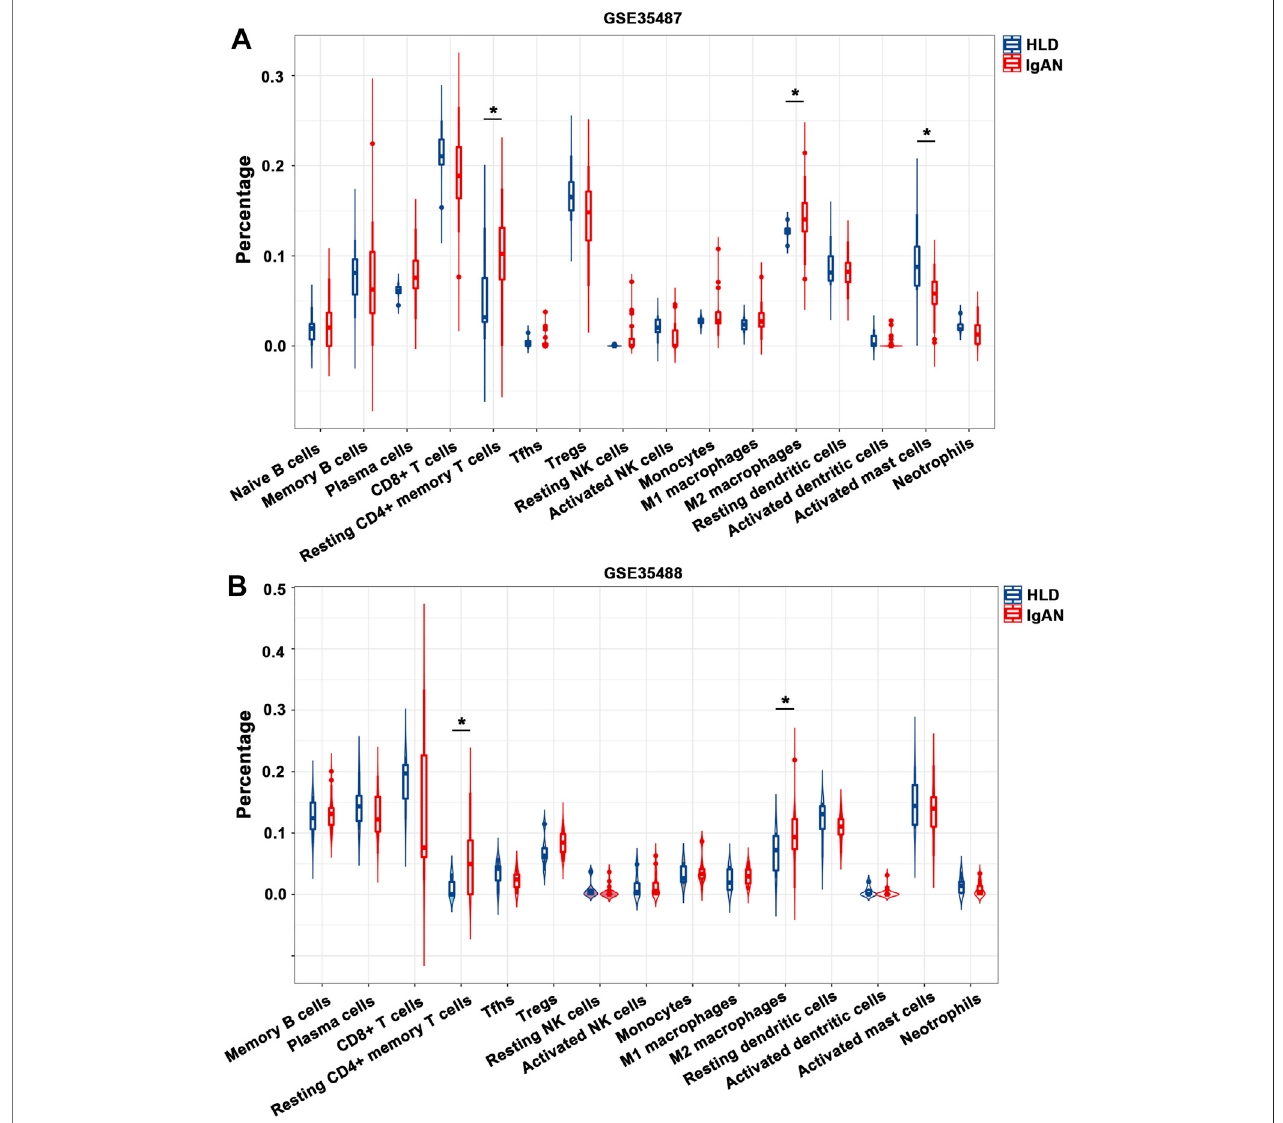
FIGURE 6 | Composition of in fi ltrating immune cell subpopulations in kidney tissues from IgAN patients. (A) Violin diagram of the proportion of immune cells in GSE35487. (B) Violin diagram of the proportion of immune cells in GSE35488. HLD, healthy living donor; IgAN, IgA nephropathy.